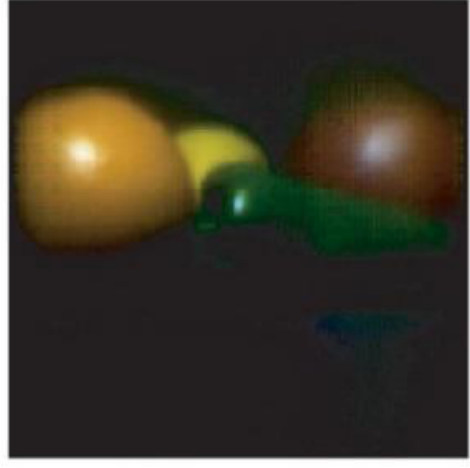
Figure 16. Spectrum to RGB converted image.